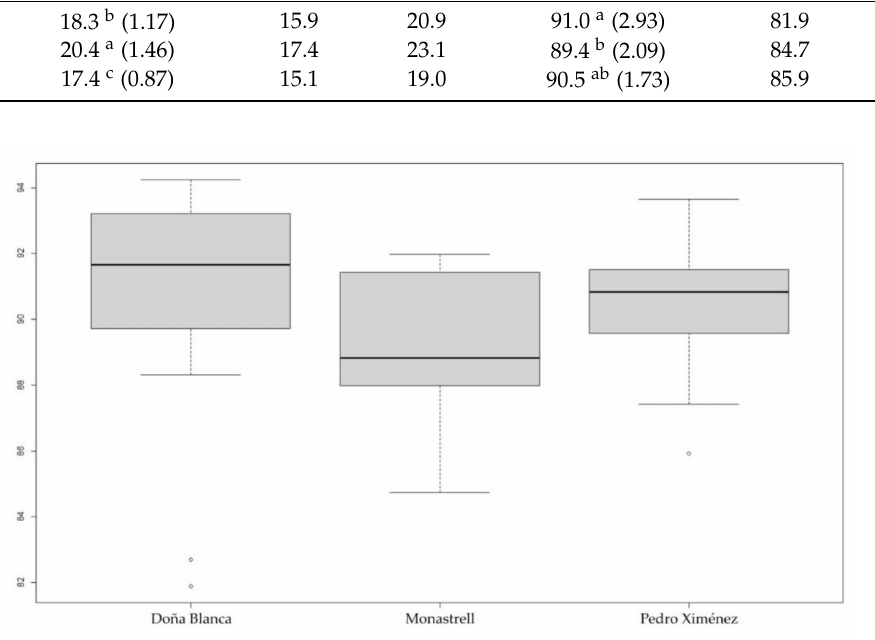
Figure 19. Box-plot representations showing the distribution of J index values in cultivars Doña Blanca, Monastrell and Pedro Xim é nez with the Doña Blanca